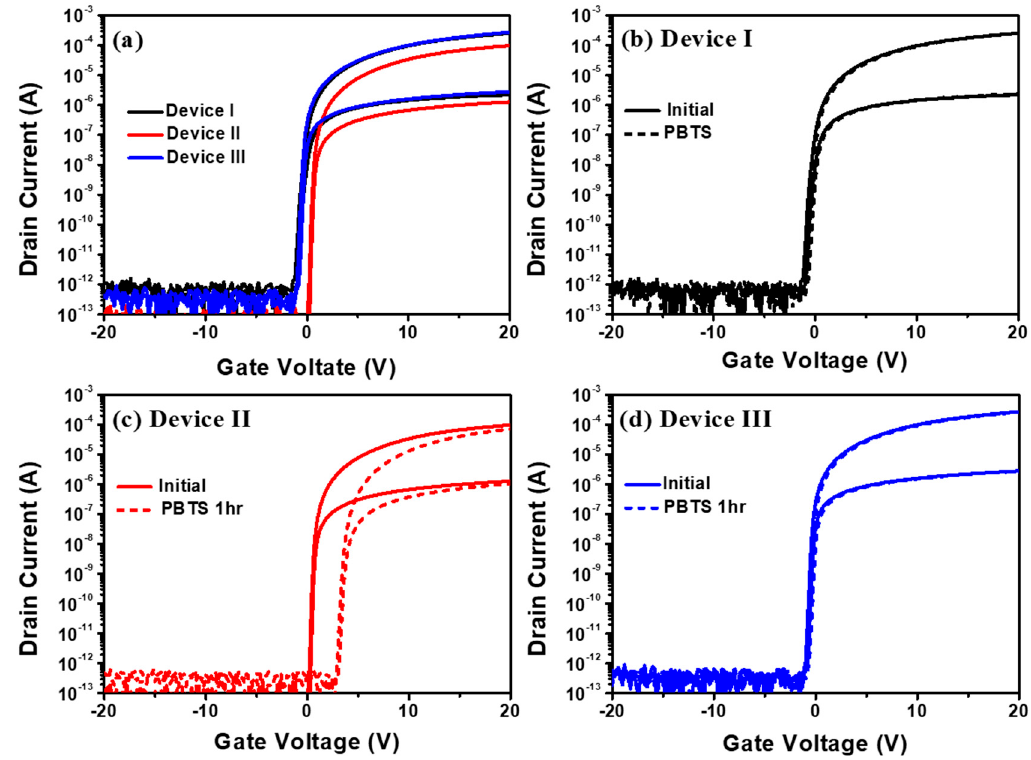
Figure 1. Cross-sectional view of the coplanar indium–gallium–zinc–oxide (IGZO) thin-film transistor (TFT) studied in this work.